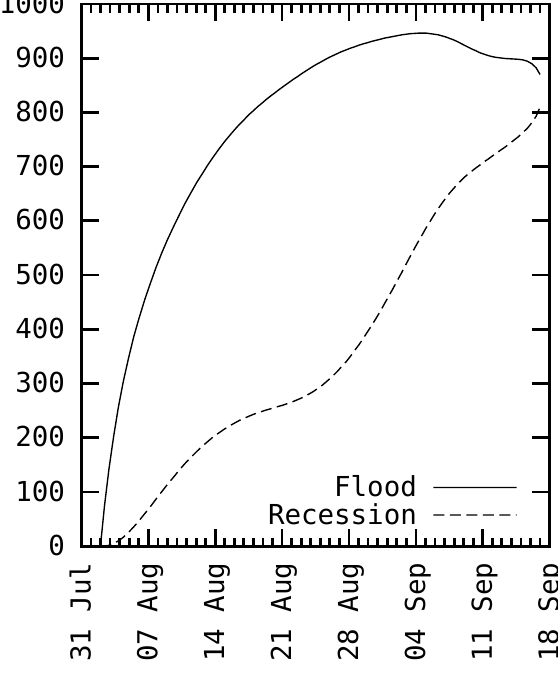
Fig. 18. Distance of the flood head and tail along the Indus channel from the foot of the northern ranges at 71 ◦ N, 32 ◦